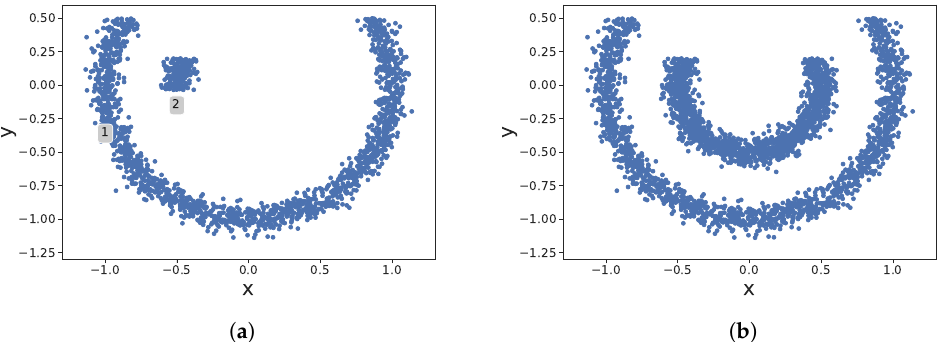
Figure 5. The Horseshoe synthetic dataset. ( a ) The first 1870 samples from the Horseshoe dataset. ( b )The Horseshoe dataset.